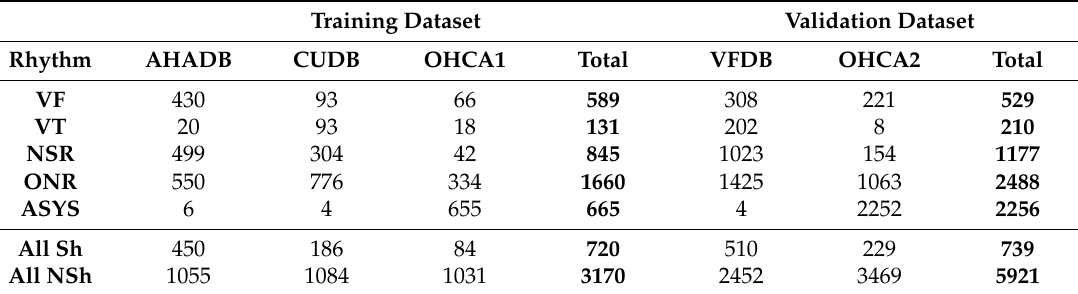
Table 1. Number of 10 s strips in the training and validation datasets, collected from Holter and OHCA databases with respective arrhythmia annotations.